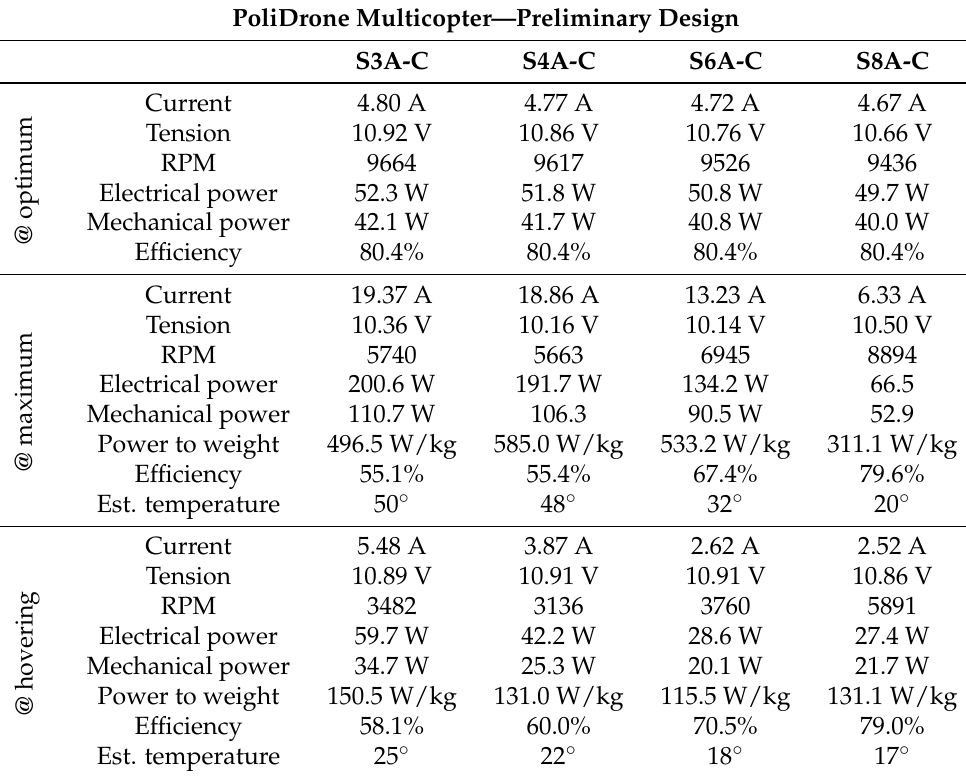
Table 11. Preliminary design of PoliDrone multicopter: single-motor performance estimations. Calculations are based on a 6000 mAh, 11.1 V battery used up to